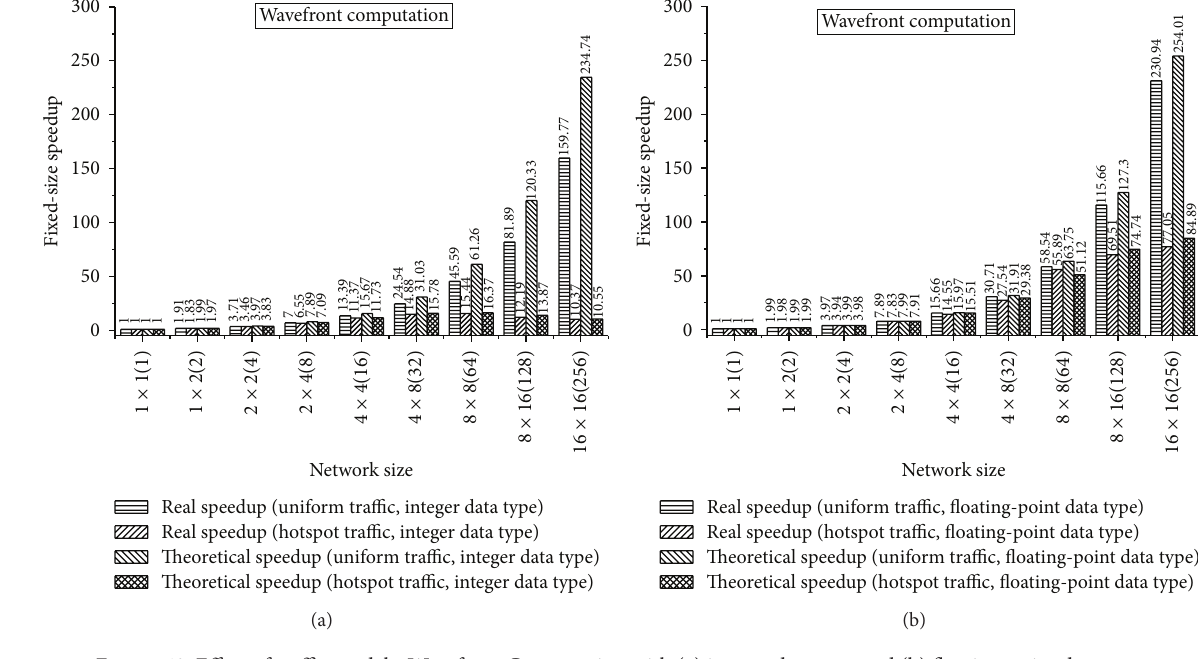
Figure 12: Effect of traffic models: Wavefront Computation with (a) integer data type and (b) floating-point data